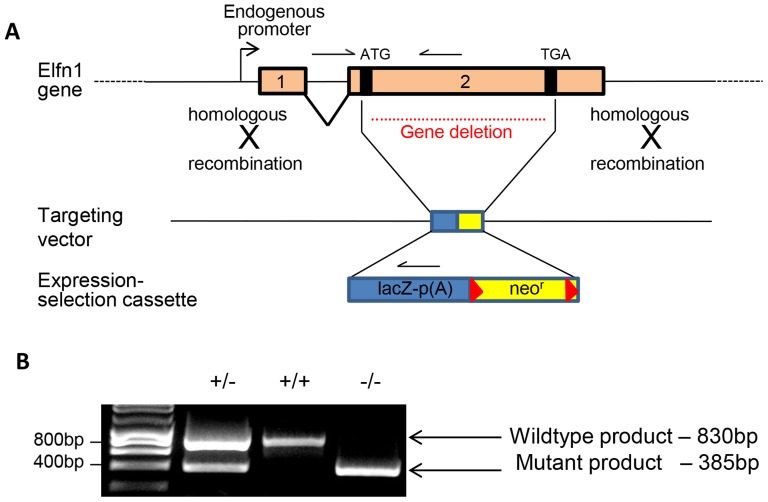
Elfn1 targeted allele.(A) Schematic of the targeting vector and the Elfn1 locus (adapted from the Knockout Mouse Project (KOMP); null allele targeting strategy (www.velocigene.com/komp/detail/10112). The full coding sequence is contained in exon 2, and this region is replaced by the expression-selection cassette. LacZ, β-galactosidase coding sequence; Neor, neomycin phophotransferase; red triangles represent loxP sites. Genotyping primers are represented by half arrows. (B) PCR genotyping of genomic DNA from Elfn1+/−, wildtype and Elfn1−/− mice. Resultant PCR product sizes are 830bp (wildtype) and 385bp (Elfn1-targeting vector fragment).